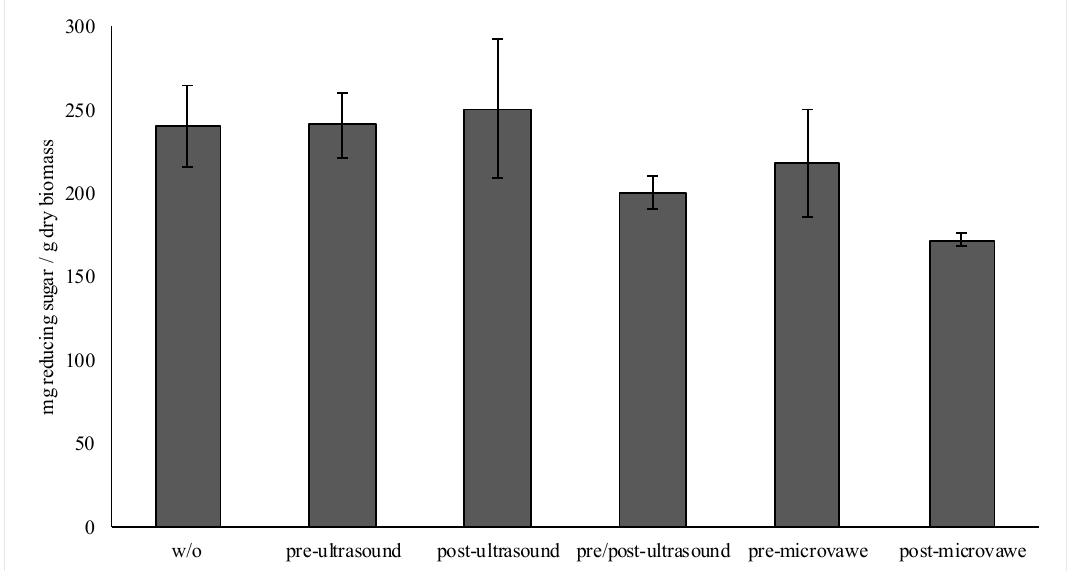
Figure 4. The amount of reducing sugar produced per g dry hay biomass when hydrolyzed with enzyme preparations that have been treated with ultrasound or microwave pre and post fungal cultivation and prior to enzyme precipitation and extraction. Bars represent the average of 6 to 12 individual tests; w/o—without any additional treatment step.